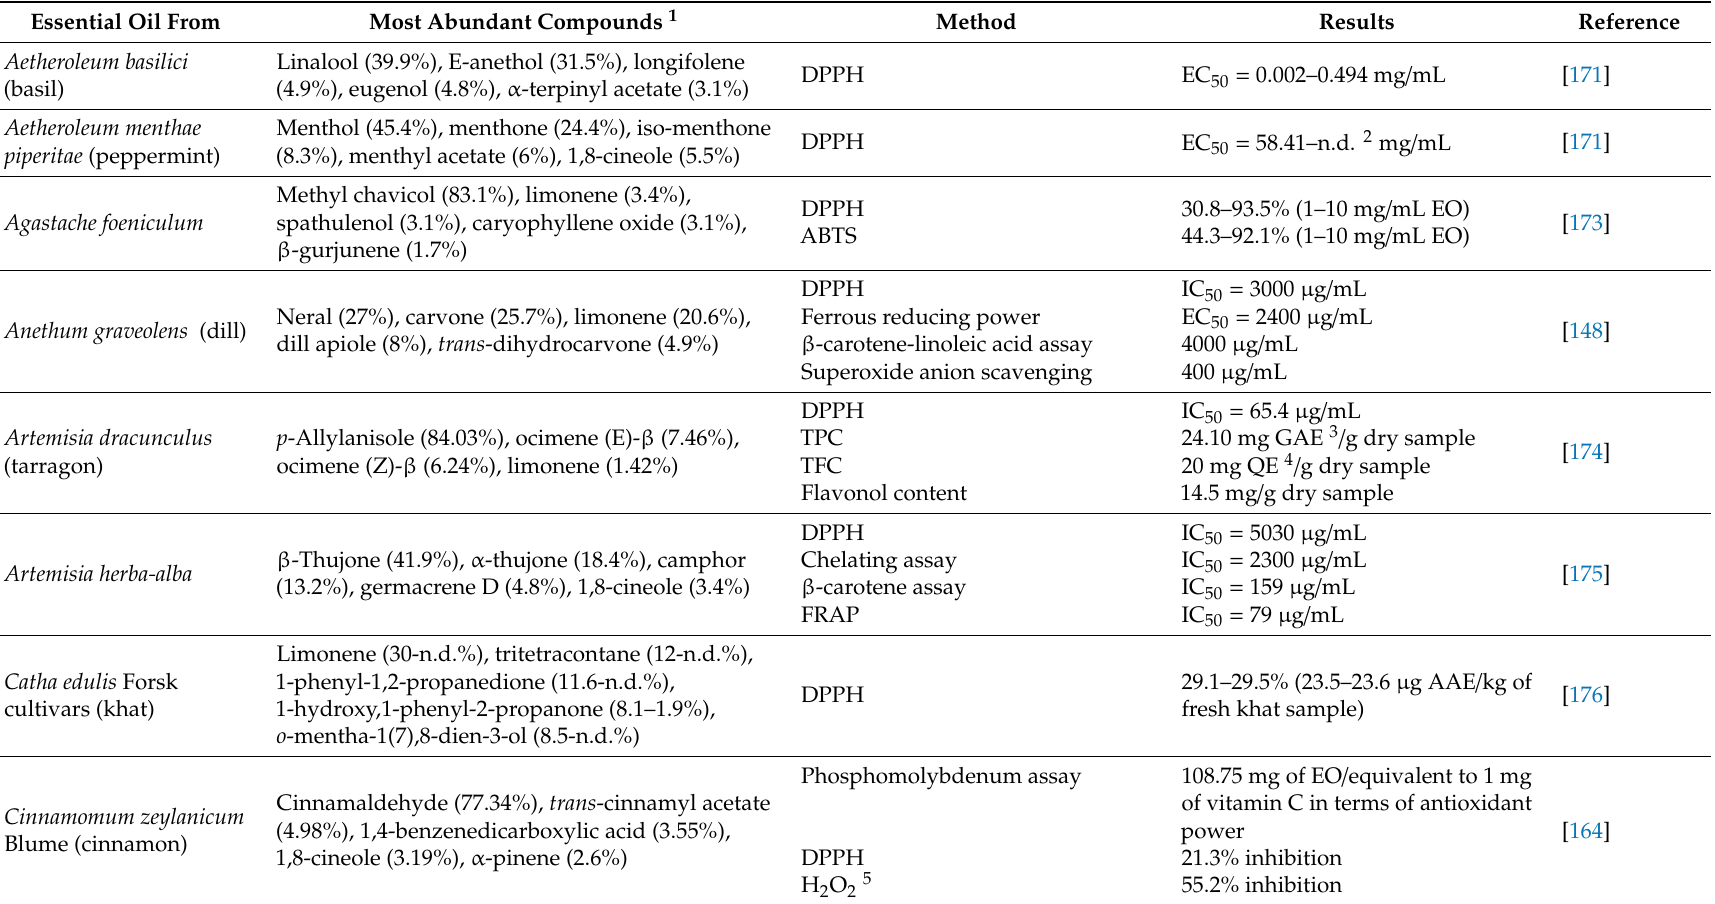
Table 4. Overview of studies about antioxidant properties of essential